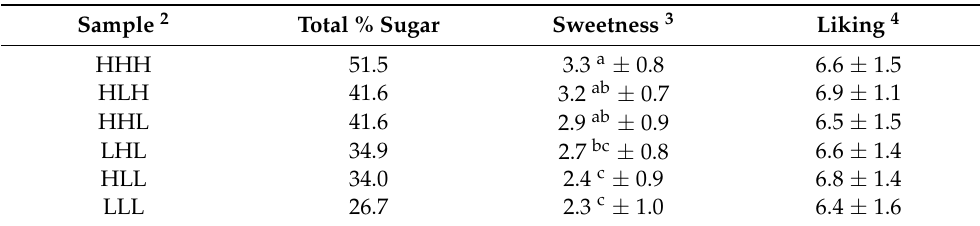
Table 3. Total % sugar ( w / w ) and mean sweetness and liking ± standard deviation 1 for the 3D printed chocolates ( n =